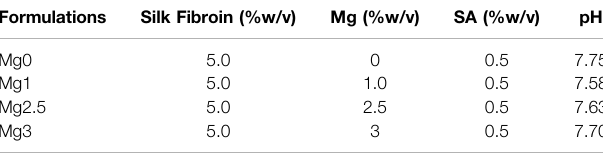
TABLE 1 | Formulations of SF-SA/MgP hybrid bioinks.